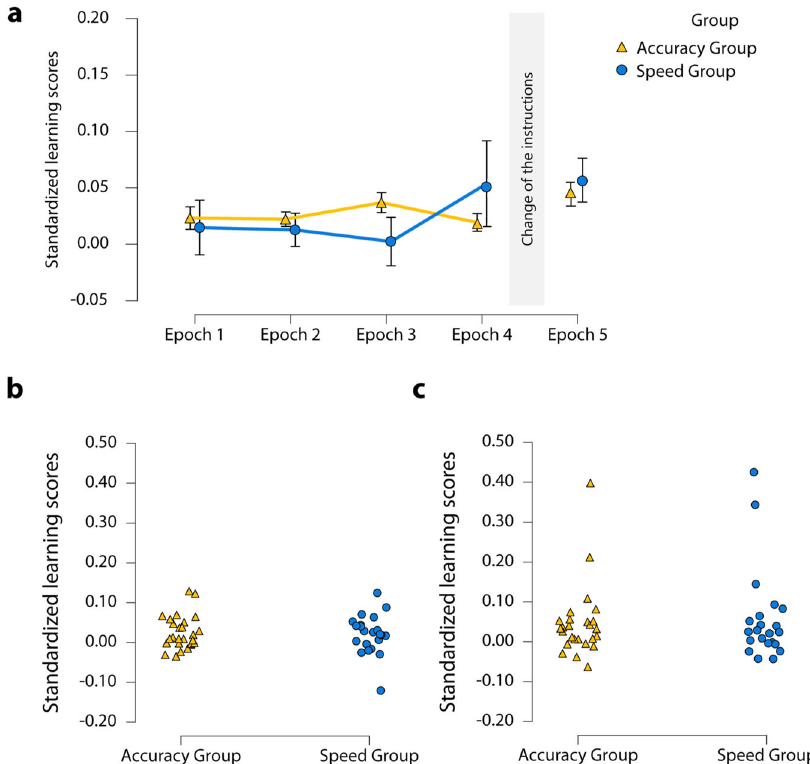
Fig. 2 Learning of serial-order-based regularities. a The dynamics of learning of serial-order-based regularities with accuracy or speed instructions. The y -axis represents the standardized learning scores [(random high-probability trials − pattern high-probability trials in the given epoch)/median RTof the given epoch], and the x -axis of the fi ve epochs (the fi rst four are of the Different Instruction Phase, and the fi fth one is of the Same Instruction Phase). The Accuracy Group is presented with yellow, while the Speed Group with blue color. Error bars represent standard error of the mean. Both groups show equal learning in both phases. b Individual data of the lack of signi fi cant main effect of Group of serial-order-based learning in the Different Instruction Phase. Triangles and dots represent the individual data points. c Individual data of the lack of signi fi cant main effect of Group of serial-order-based learning in the Same Instruction Phase. Triangles and dots represent the individual data